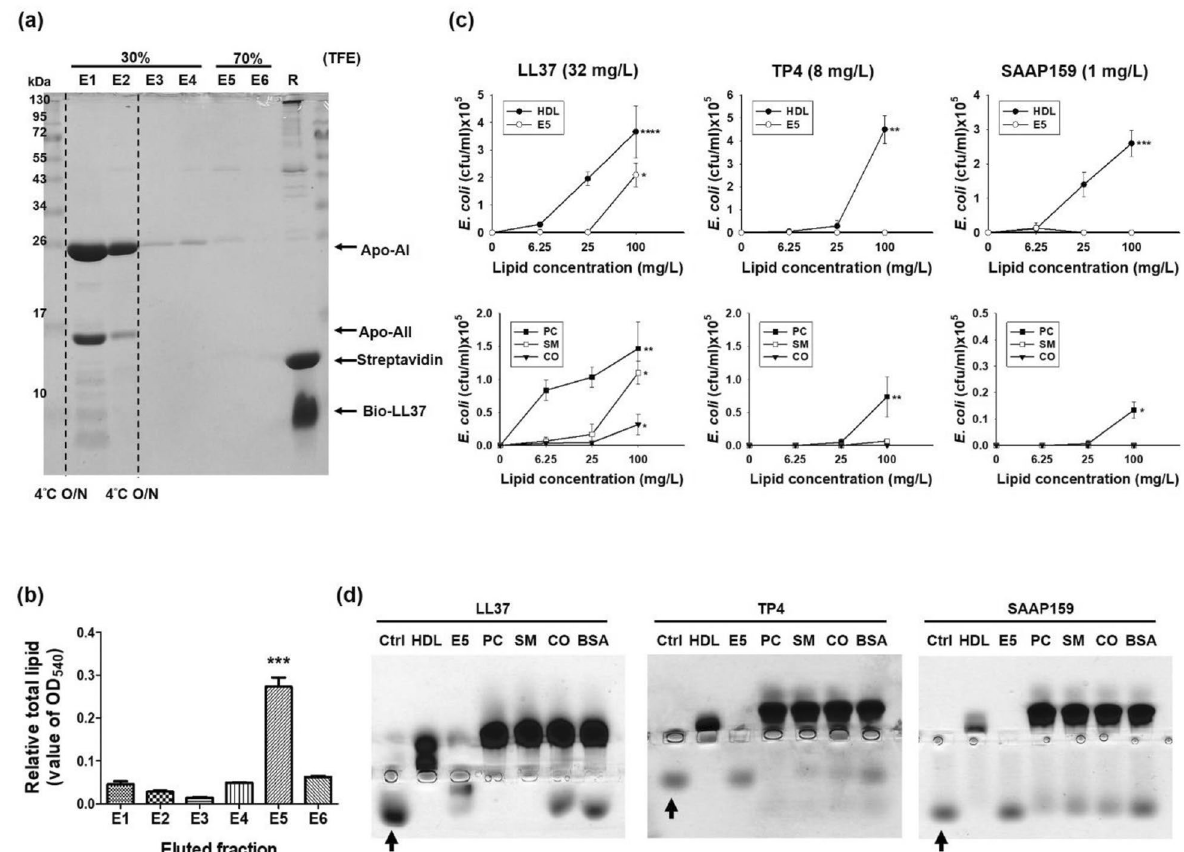
Figure 3. Roles of lipids in the HDL for AMP-binding. ( a ) Purification of human serum components responsible for AMP-binding. The human serum components were pulled down by immobilized LL37, stepwise eluted by 30% and 70% TFE after overnight incubation at 4 °C, and analyzed by 15% non-reducing SDS-PAGE. ( b ) Lipid contents of the eluates (E1–E6). Significance is calculated according to One-way ANOVA test. *** indicates P ≤ 0.0005 which E5 compared with each other groups. ( c ) Effect of HDL, eluate E5 (top panel) and various lipids (bottom panel) on the antimicrobial activities of AMPs against E. coli (10 6 cfu/ml). Values are the mean ± SD (n = 3). Kruskal–Wallis tests were performed to determine the significance of the difference in each group. * Indicates P ≤ 0.05, ** Indicates P ≤ 0.005, *** Indicates P ≤ 0.0005, **** Indicates P ≤ 0.00005. ( d ) Band shift of AMPs by 10 µg HDL, E5 and various lipids (4 µg each, dissolved in 20 µg/10 µl BSA) and analyzed by 8% horizontal native PAGE and Coomassie blue staining. Arrow indicates control (non-shift) AMP. PC: phosphatidylcholine; SM: sphingomyelin; CO: cholesteryl oleate; BSA: bovine serum